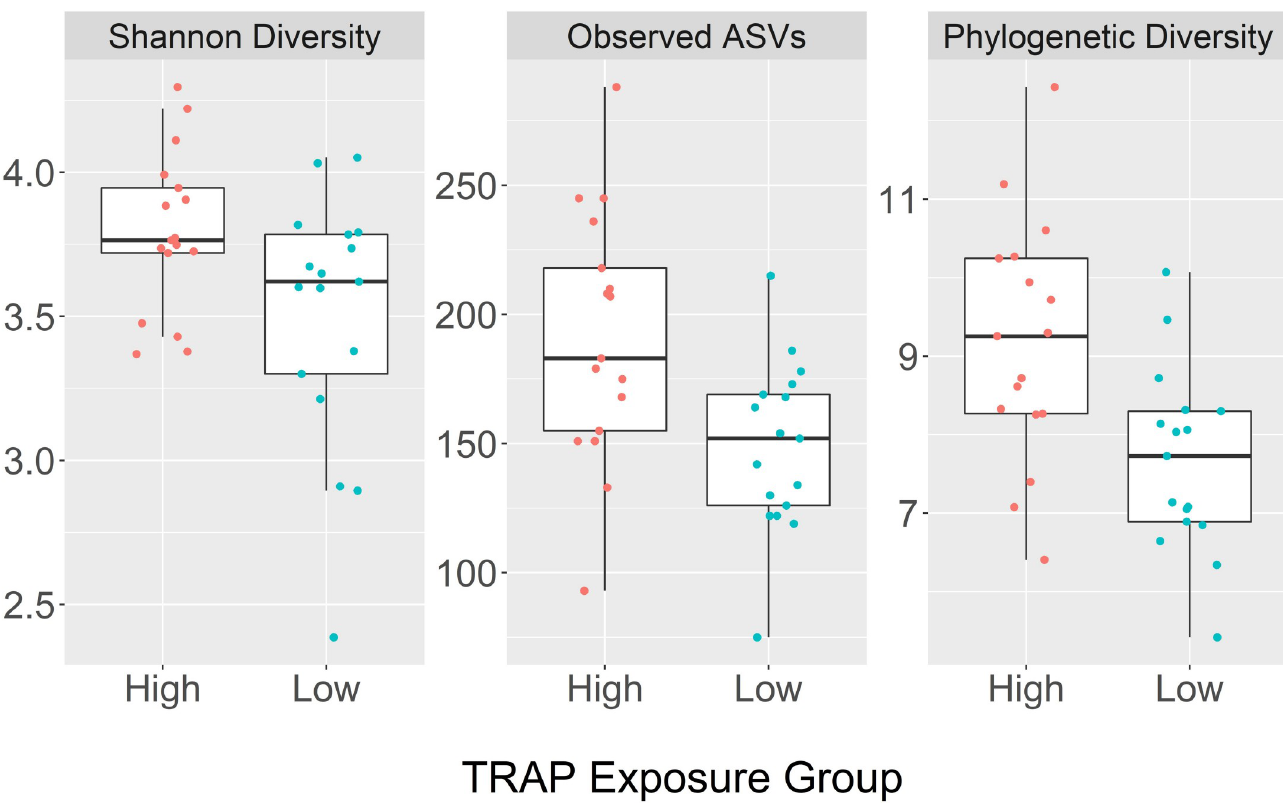
Fig 3. Box plots comparing bacterial diversity indices in sputum between high and low traffic-related air pollution (TRAP) exposure groups; Shannon diversity, number of observed amplicon sequence variants (ASVs), and Faith’s phylogenetic diversity.